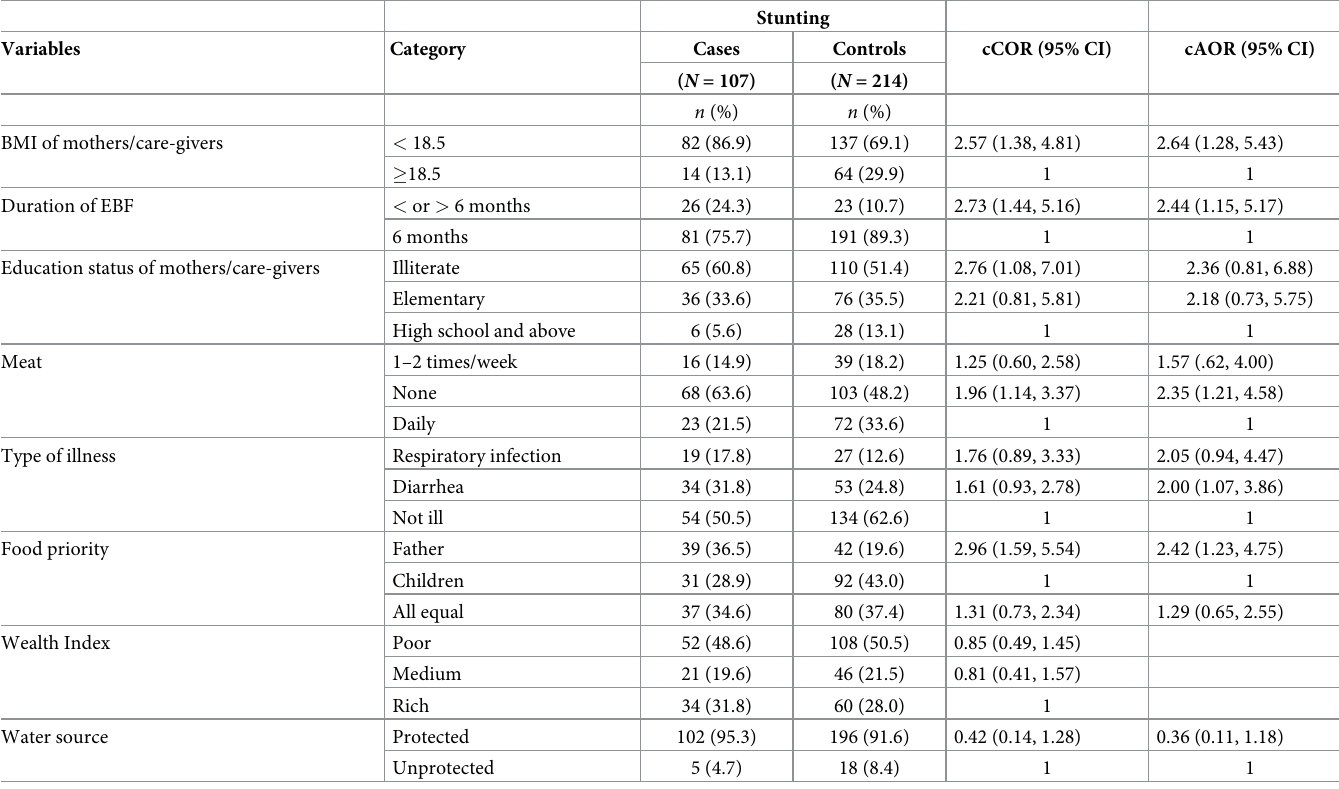
Table 4. Determinants of stunting among children 6–59 months old in Kemissie City Administration, Oromia special zone, northeastern Ethiopia, January to April